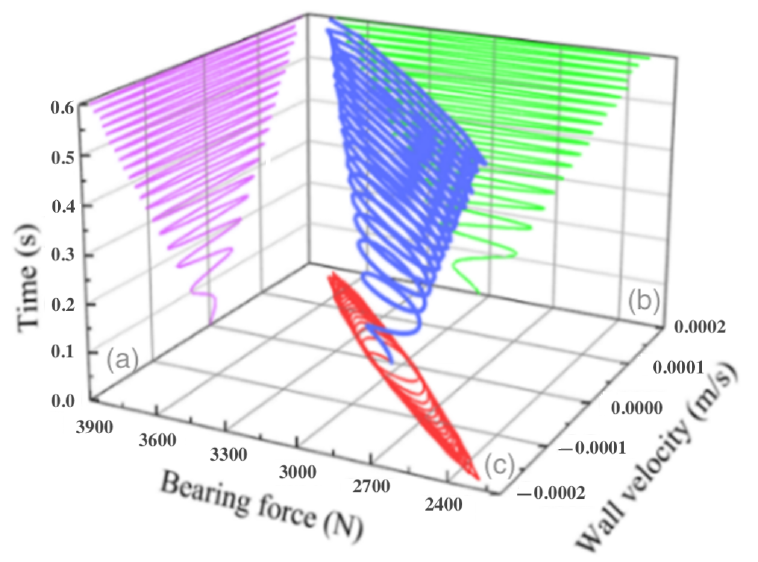
Figure 9. Relationships between supporting load capacity, film surface velocity and simulation time: (a) relationship between film surface velocity and simulation time; (b) relationship between supporting load capacity and film surface velocity; (c) relationship between supporting load capacity and film surface velocity.